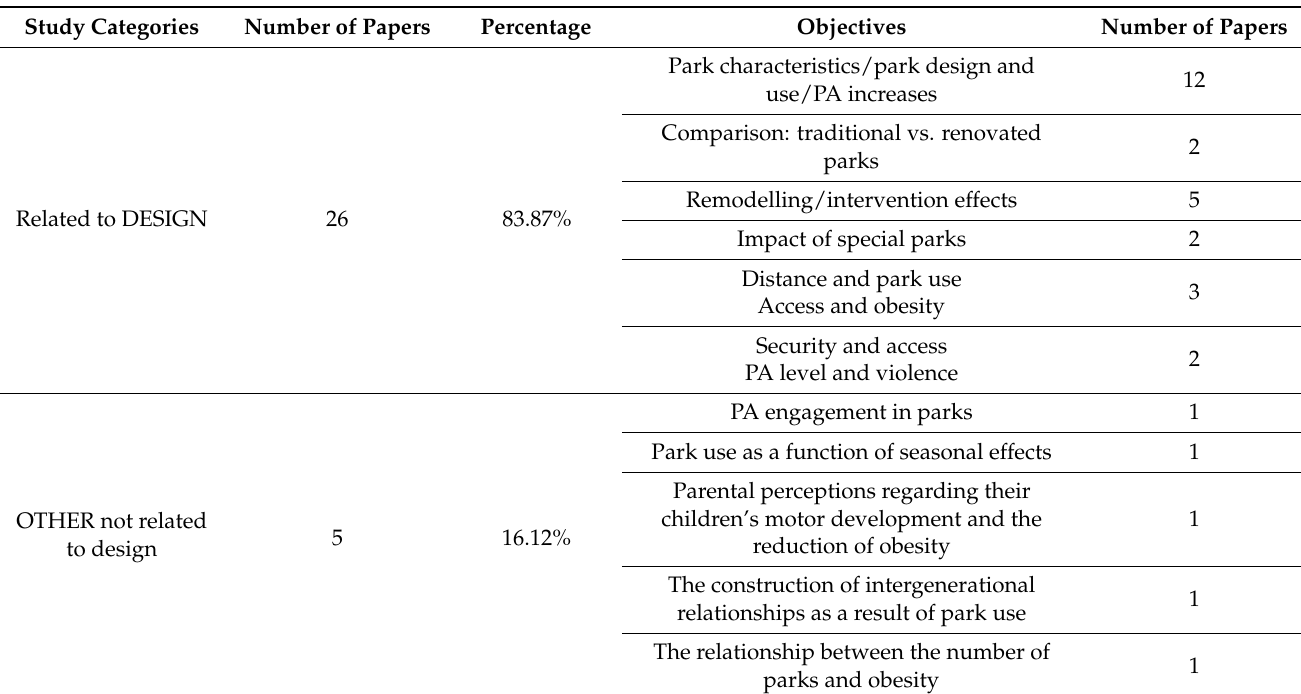
Table 7. Research